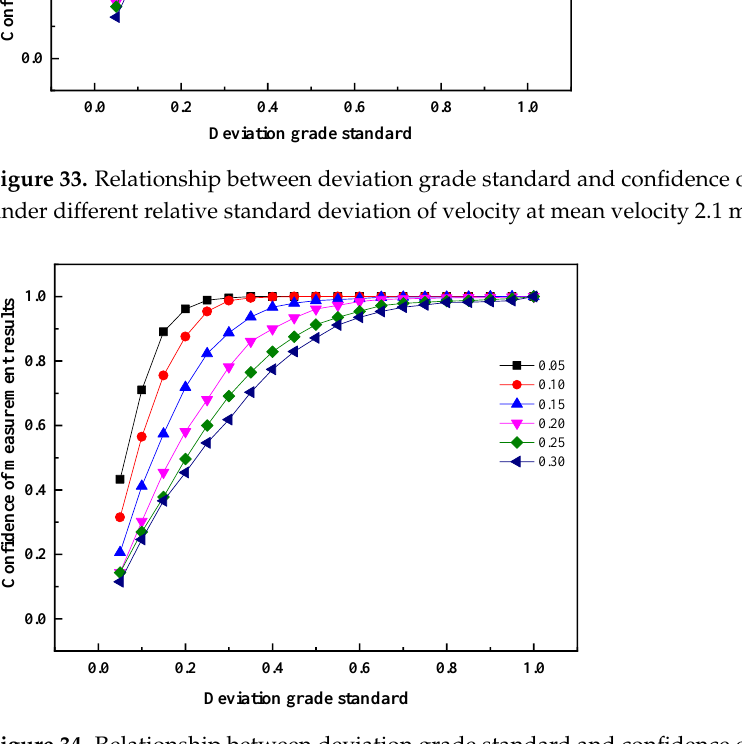
Figure 34. Relationship between deviation grade standard and confidence of measurement results under different relative standard deviation of velocity at mean velocity 3.2 m/s.